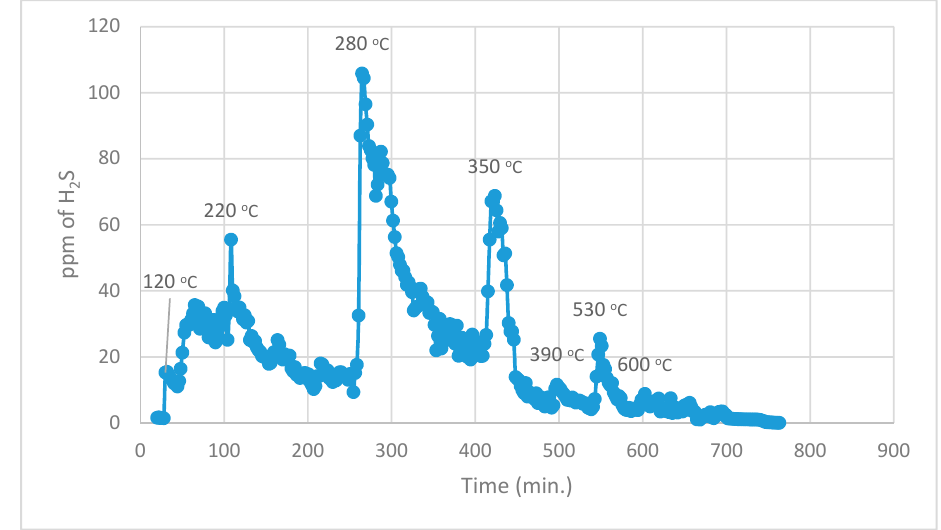
Figure 8. TPR of treated POW2 coal.